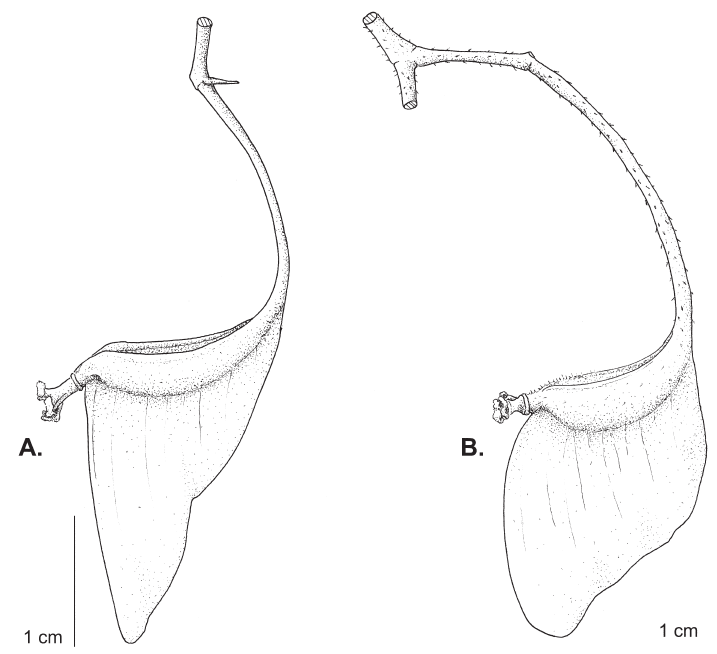
Fig. 26. Difference in fruit shape. A . B. griffithiana (A.DC.) Warb. B . B. nepalensis (A.DC.) Warb . Drawn by Rebecca Camfield. A from Griffith 203 (K) and 2504 (K); B from Stainton 8906 (E) and Cave s.n.